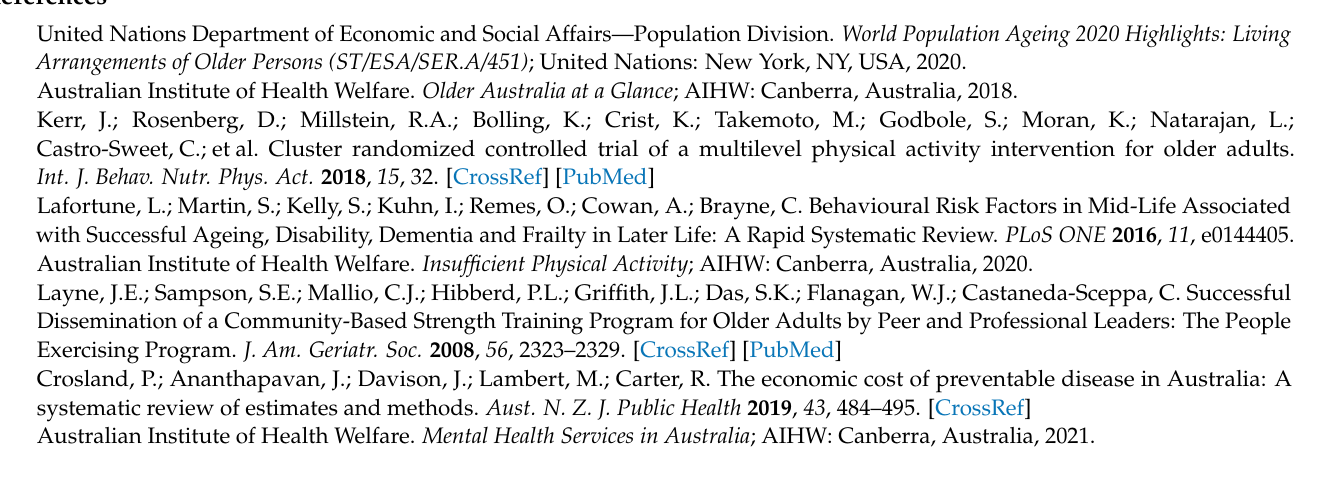
study based on CONSORT items. Table S3. Detailed description of included studies, File S1: Risk of bias assessments for each